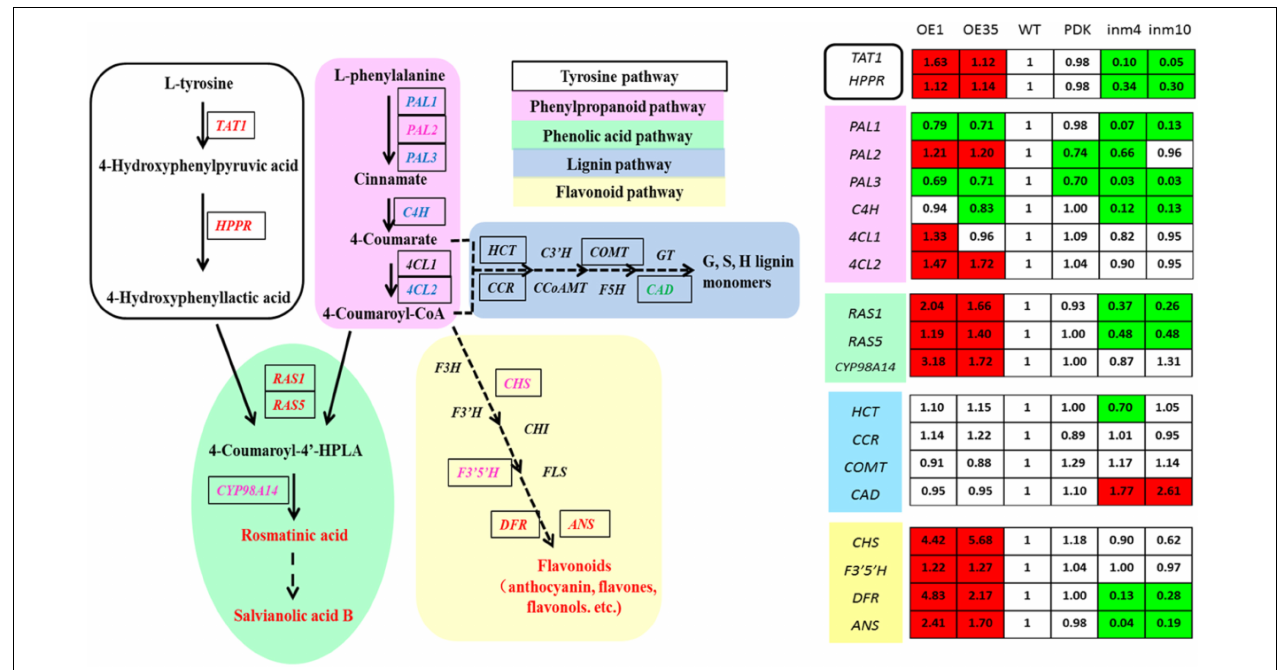
FIGURE 7 | Relative expression levels of 19 phenolics-pathway genes in SmbHLH51 -overexpressing and SmbHLH51 -RNAi Salvia miltiorrhiza were analyzed by RT-qPCR. The data represent fold changes of phenolics-pathway genes compared with the wild type (WT). Red box indicates the data is significantly upregulated compared with the WT ( p < 0.05, Student’s t -test); green box indicates the data is significantly downregulated compared with the WT ( p < 0.05, Student’s t -test). The following genes were retrieved from GenBank databases: TAT1 (DQ334606.1), HPPR (DQ099741.1), PAL1 (EF462460.1), PAL2 (GQ249111.1), PAL3 (KF220569.1), C4H (DQ355979.1), 4CL1 (AY237163.1), 4CL2 (AY237164.1), RAS1 (FJ906696.1), RAS5 (KF220573.1), CYP98A14 (HQ316179.1), CAD (HQ162287.1), CHS (KF255832.1), F3’5’H (MH447665.1), DFR (MH447664.1), ANS (MH447663.1). HCT (Smil-00001226), CCR (Smil-00000329) and